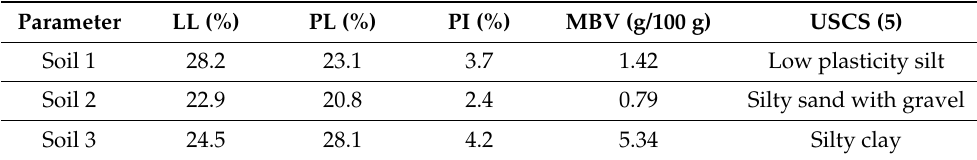
Figure 2. Soil particle size distribution after crushing. Table 4. Atterberg limits and methylene blue values of the crushed soil.